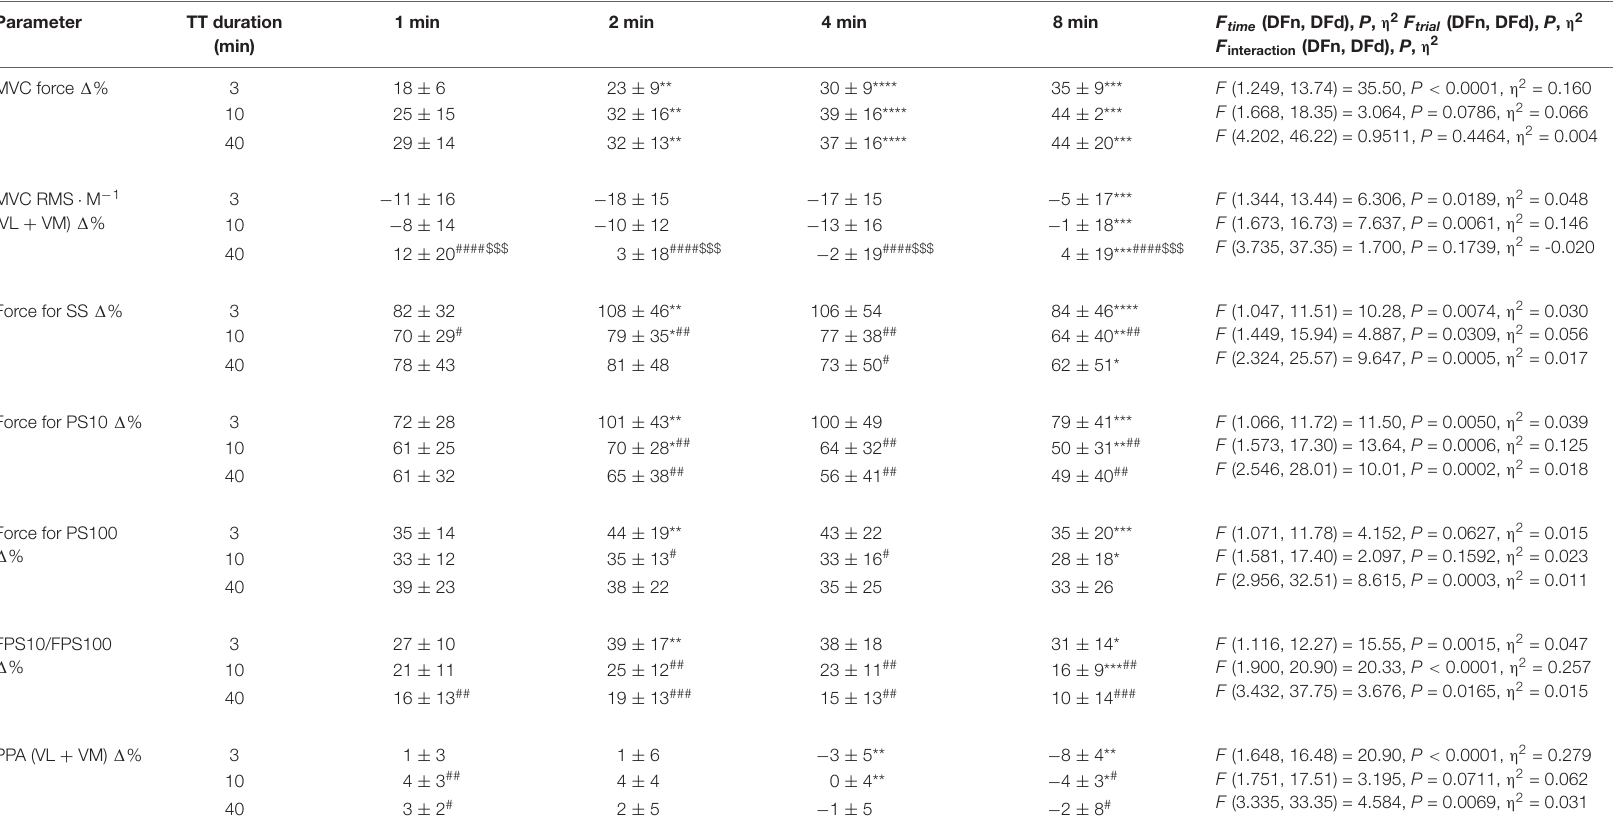
Values are expressed as percentage change from end of TT (n = 12, except n = 11 for MVC RMS · M − 1 VL and PPA VL). MVC, maximal voluntary contraction; RMS, root mean square; M, M-wave; VL, vastus lateralis; VM, vastus medialis; SS, single stimulus; PS10, paired stimuli at 10 Hz; PS100, paired stimuli at 100 Hz; FPS10/FPS100, ratio of force for PS10 vs. PS100; PPA, peak-to-peak amplitude of the M-wave. *Different from previous. # Different from 3-min TT. $ Different from 10-min TT. The number of symbols indicate significance at *P < 0.05; **P < 0.01; ***P < 0.001; ****P < 0.0001; ## P < 0.01; ### P < 0.001; #### P < 0.0001; $$$ P <